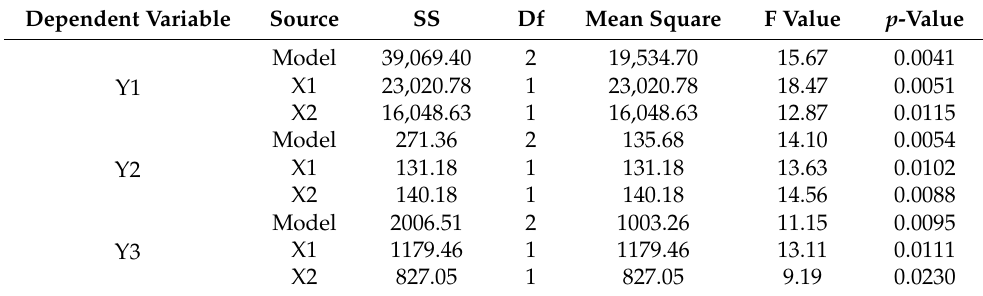
Table 3. ANOVA for Central Composite Design of QTF loaded